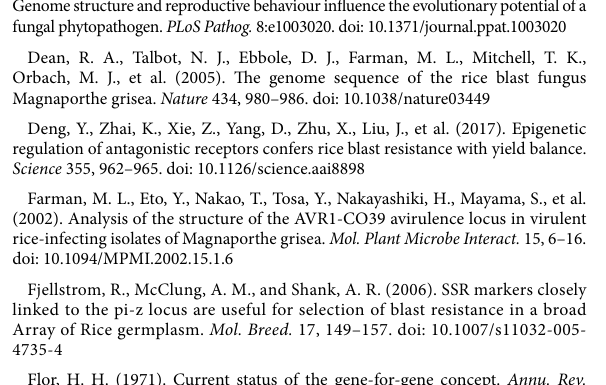
SUPPLEMENTARY TABLE 1 Primers used for PCR diagnosis of avirulence and resistance genes. SUPPLEMENTARY TABLE 2 List of 117 cultivars bred over five decades periods of time that were used for field evaluation of M. oryzae